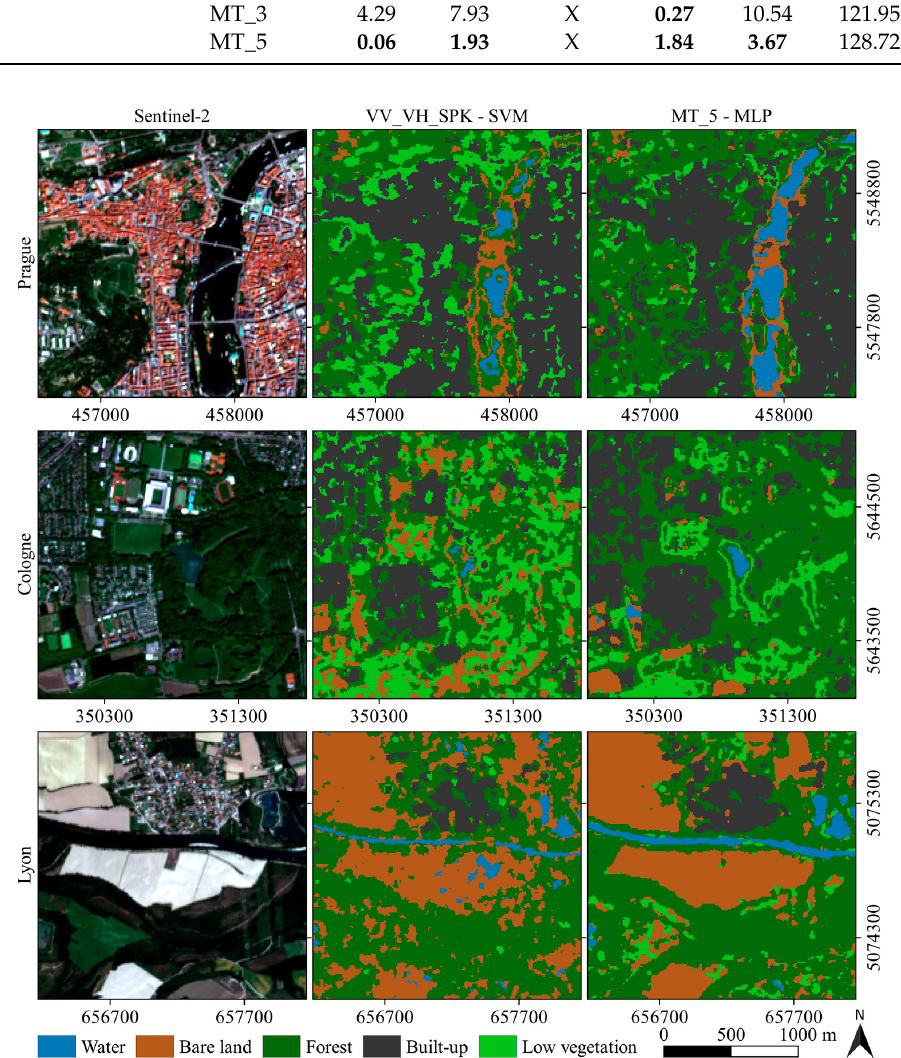
Figure 6. Example subset of each study area shown as Sentinel-2 “true-color“ composite ( left ); Figure 6. ExamplesubsetofeachstudyareashownasSentinel-2“true-color“composite( left ); classification classification map using single-date S1 imagery and support vector machine (SVM) classifier map using single-date S1 imagery and support vector machine (SVM) classifier ( middle ); classification ( middle ); classification map using multitemporal imagery (five scenes) and multi-layer perceptron map using multitemporal imagery (five scenes) and multi-layer perceptron (MLP) classifier ( right (MLP) classifier ( right ).